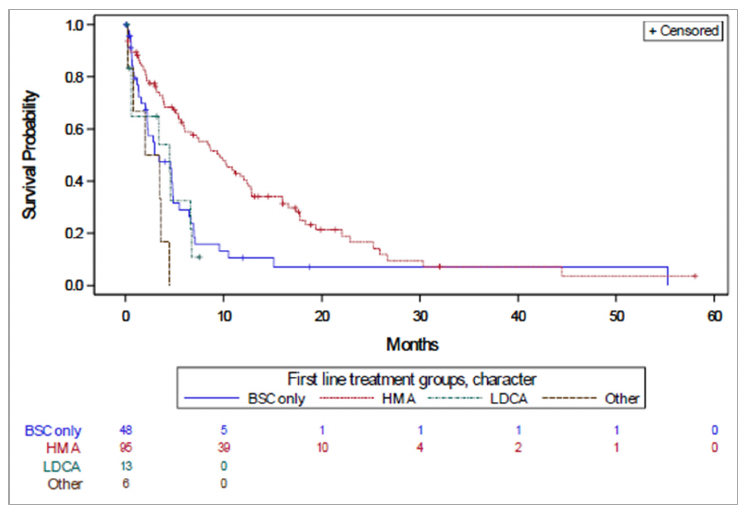
Figure 2. Time to treatment failure by first line treatment received. Table 2. Kaplan–Meier estimates of survival.